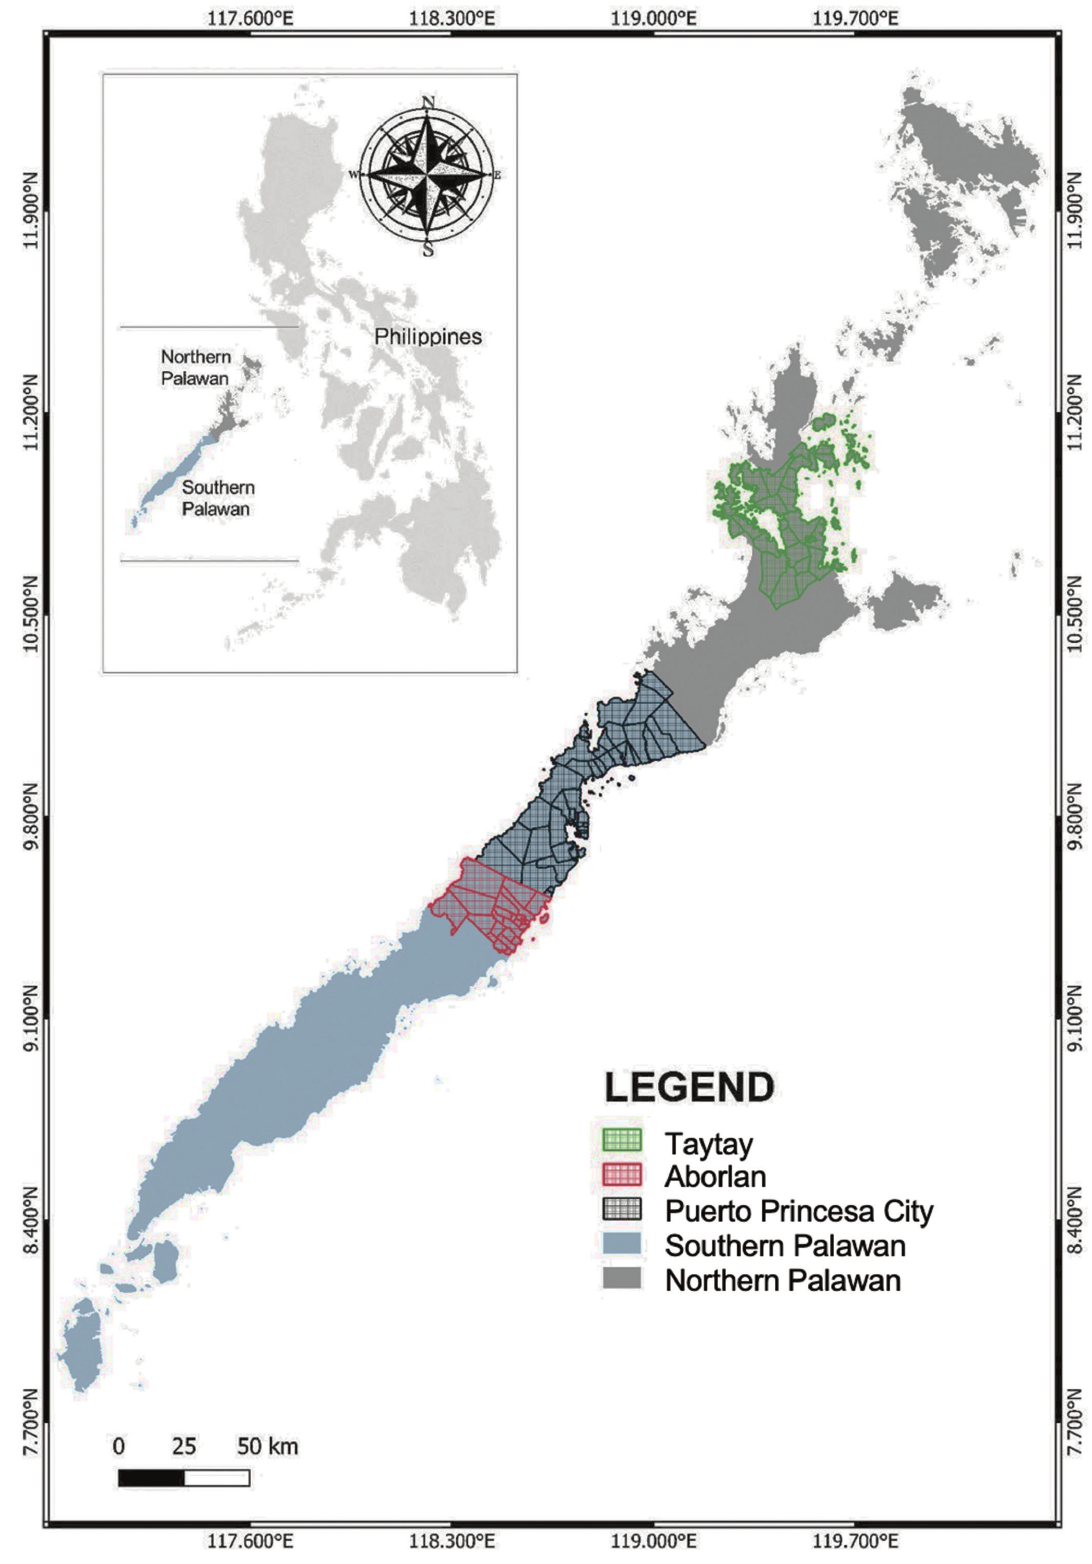
A map of Palawan, Philippines To normalise various conditions across the multi-temporal and multi-spatial Landsat datasets, it is highlighting the southern and northern divisions and three of the GCRF BC’s imperative that Landsat data undergoes pre-processing routines to enhance the quality and remove case study areas – Puerto Princesa City various radiometric and geometric errors in each image [53–56]. Thus, radiometric calibration and and the municipalities of Taytay and atmospheric correction were employed for this study.